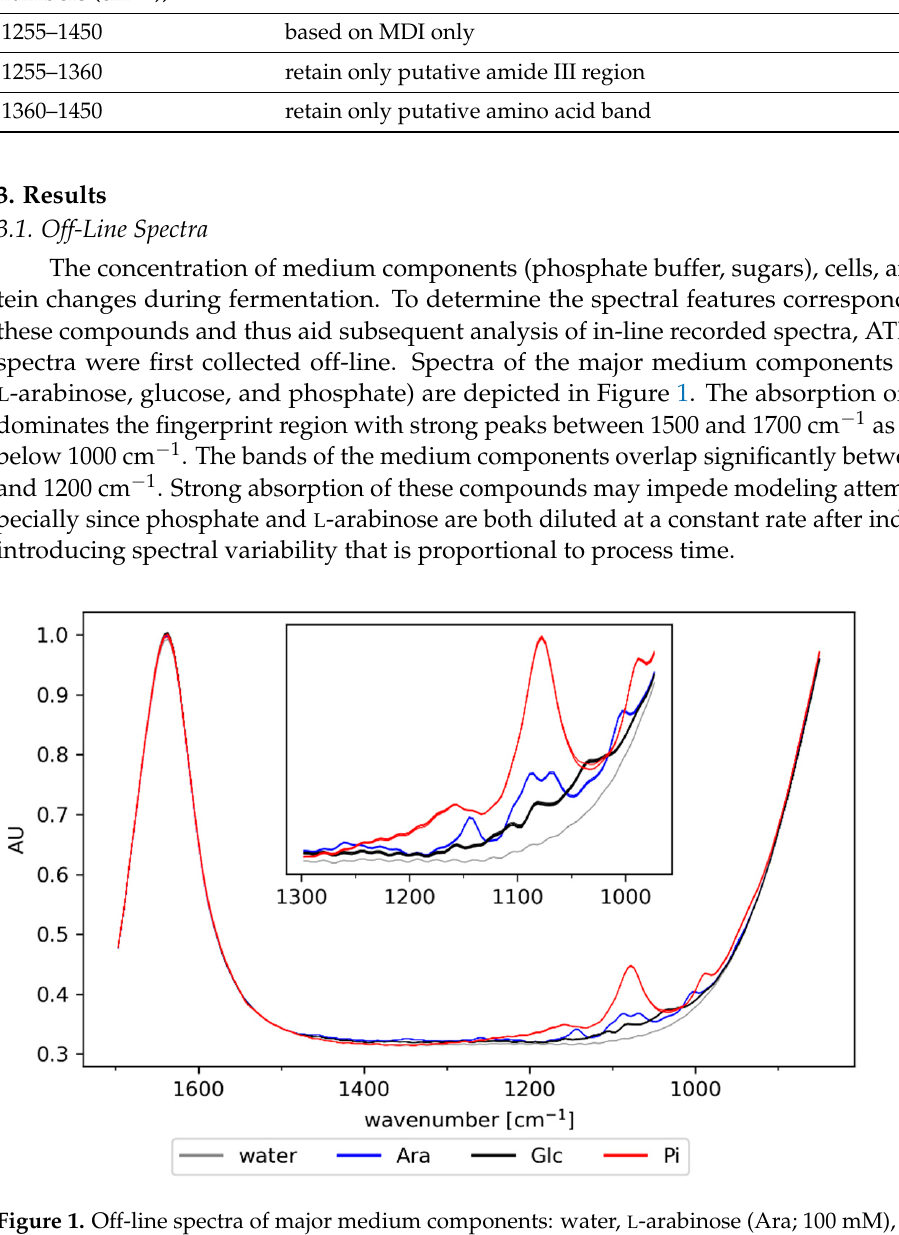
Figure 1. Off-line spectra of major medium components: water, L -arabinose (Ara; 100 mM), glucose (Glc, 55 mM), and phosphate (P i , 130 mM). Air was subtracted as background.